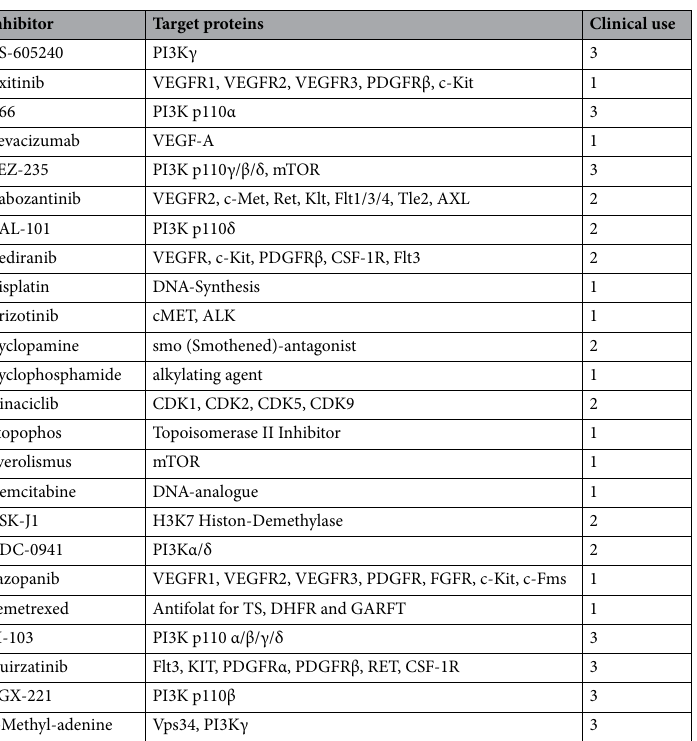
Table 1. Drugs and inhibitors used in this screen. 1 = clinically approved, 2 = clinical trial 3 = preclinical